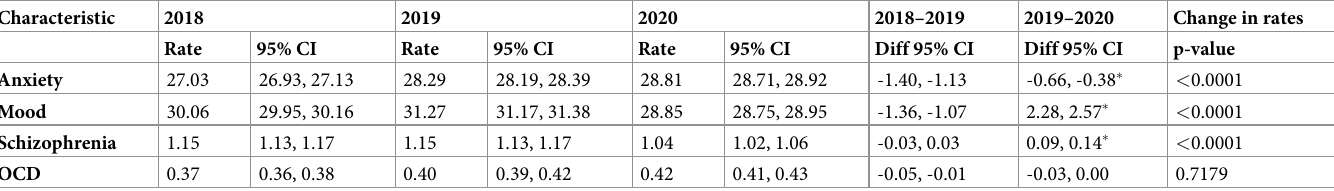
Table 1. Incidence rate per 1,000 people and trends of new psychiatric disorders between 2018 and 2020. Characteristic